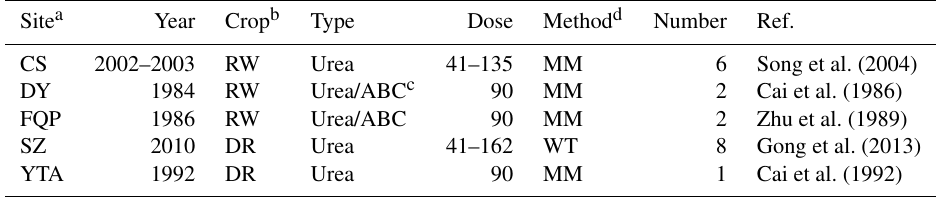
Figure 2. Location of the experimental field sites involved in this study. The sites are Changshu (CS), Danyang (DY), Dongbeiwang (DBW), Fengqiu (FQ), Guangchuan (GC), Luancheng (LC), Quzhou (QZ), Shenzhen (SZ), Yanting (YT), Yingtan (YTA), and Yongji (YJ). Table 1. Descriptive information of the studied experimental sites of rice paddy fields for model evaluation, including site name, experi- mental year (Year), crop rotation (Crop), fertilizer type (Type) and dose (Dose; kgNha − 1 ), measurement method for ammonia volatilization (Method), number of fertilization cases (Number), and reference (Ref.). Site a Year Crop b Type Dose Method